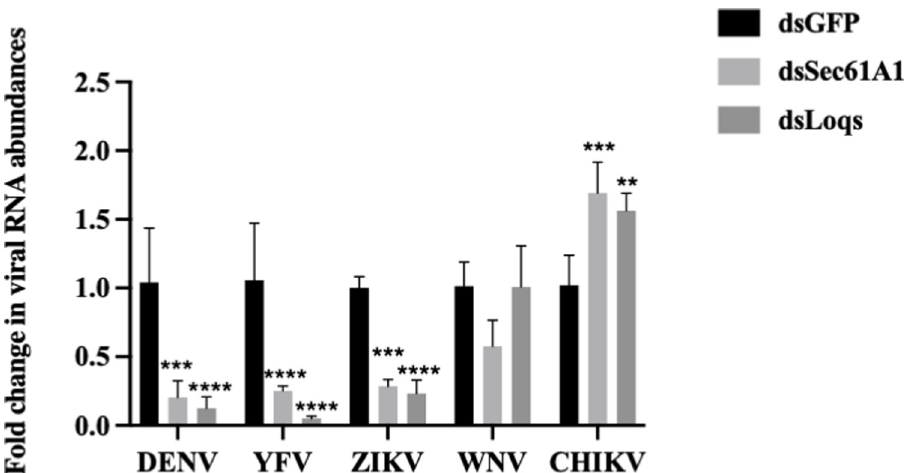
Fig 3. Effects of Loqs depletion distinct RNA virus infections. Aag2 cells were infected with dengue virus (DENV), West Nile virus (WNV), yellow fever virus (YFV), Zika virus (ZIKV) or chikungunya virus (CHIKV) at a MOI of 0.1 and harvested at 96 hrs post infection. Viral RNA abundances were measured by qPCR using specific primers. Data is represented as average fold-change over dsGFP from three independent experiments ( � p < 0.05, �� p < 0.005, ��� p < 0.001, ���� p <